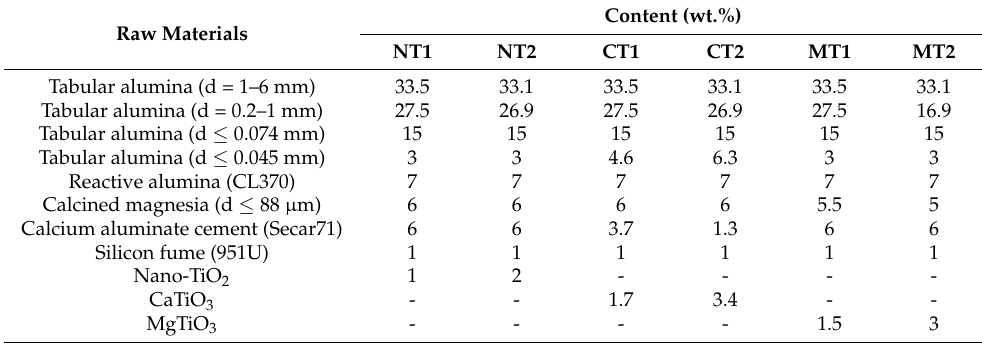
Table 2. Chemical compositions of raw materials. Raw